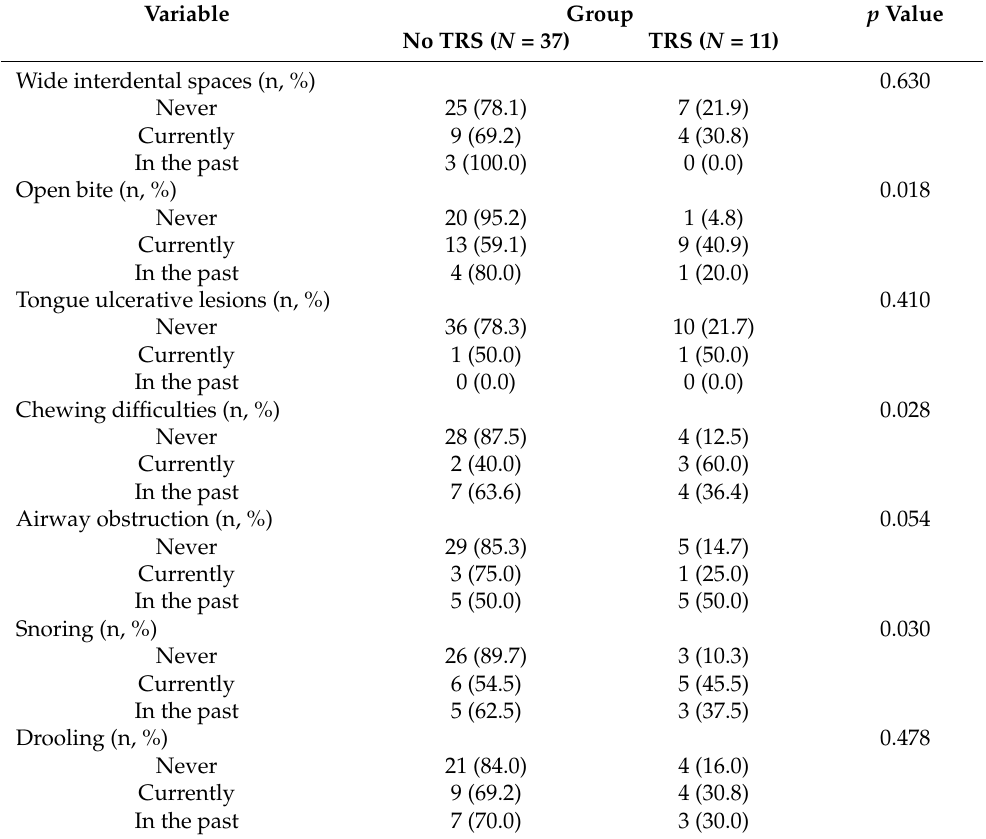
Table 5. Oral and related functional aspects according to tongue reduction surgery